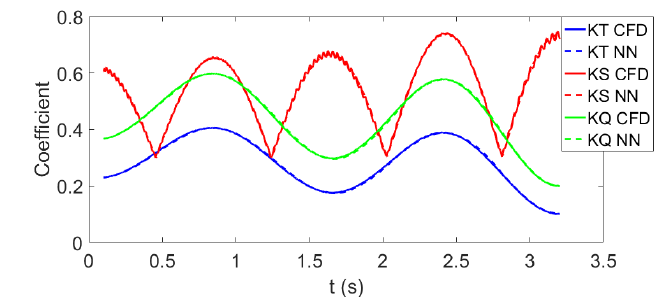
Figure 5. Coefficients as a function of time for the entire time series used for open water training. Seventy snapshots of this series were used to train the neural